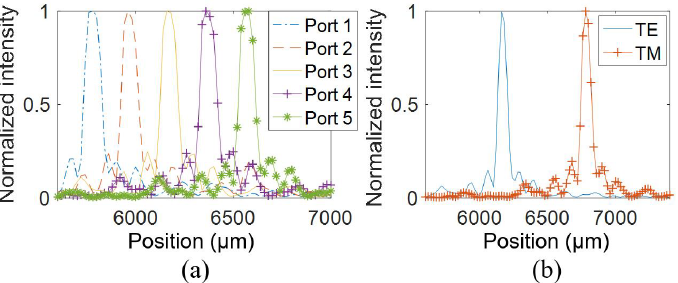
Figure 12. Far-field distributions of WSL2 at 1540 nm for ( a ) different input ports under TE polarization and ( b ) the central input Port3 under both polarizations.